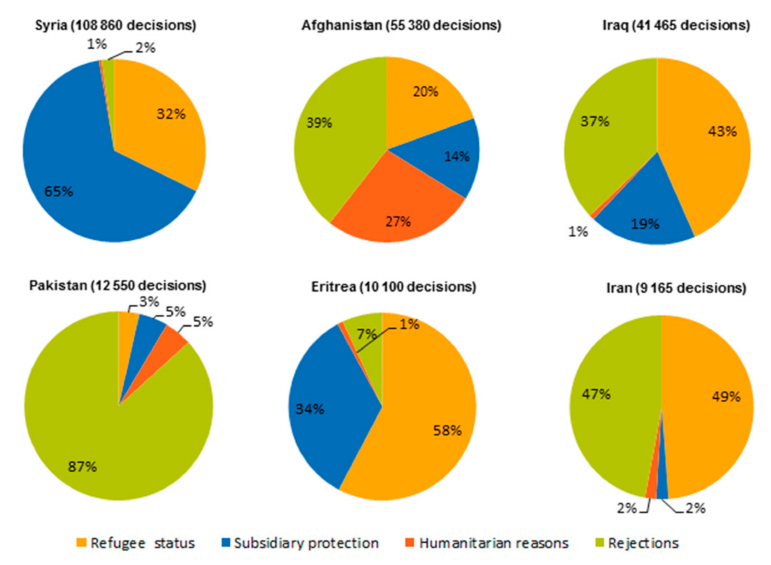
Figure 4. First instance decisions in the EU-28 by outcome, selected citizenships, 4th quarter 2016. Source: Eurostat May 2017.